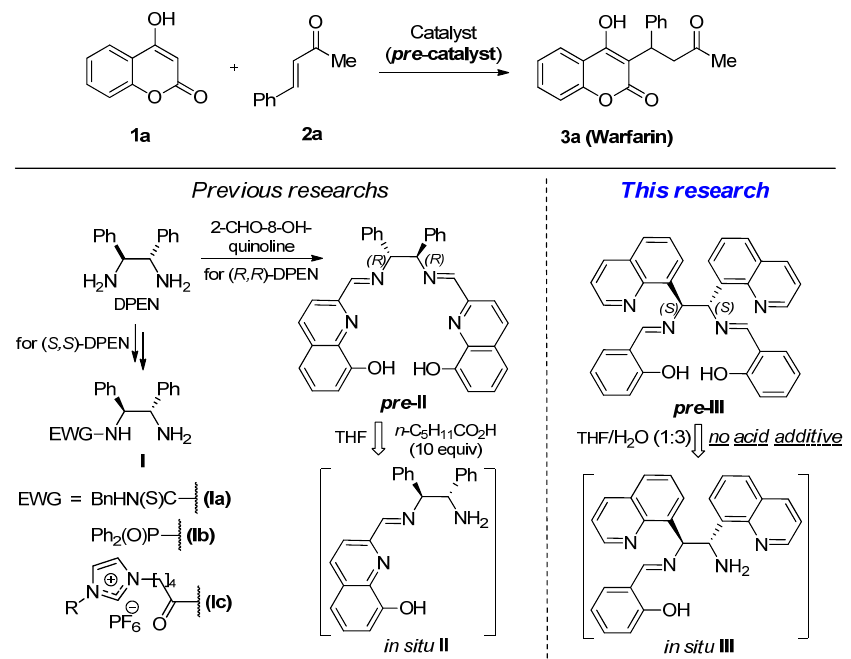
Figure 1. Research strategy for asymmetric synthesis of warfarin.